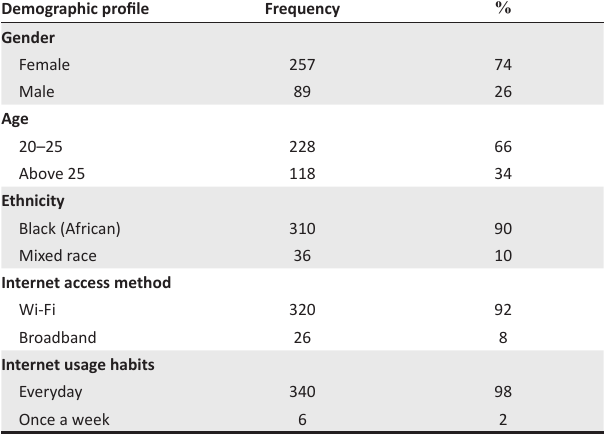
TABLE 2: Demographic profile and description of Internet usage. Demographic profile